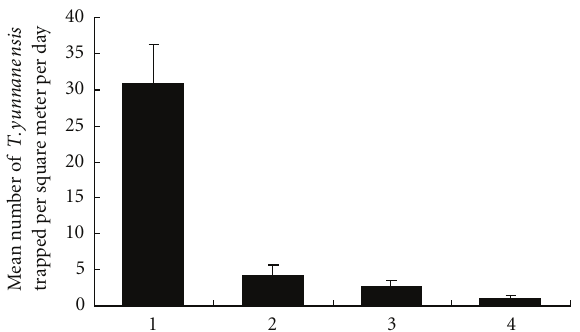
Figure 4: Mean trap catches ( ± SE) per hour of T. yunnanensis on periderm-peeled log bundles during the day (Dec.–Feb. 2006, 2007; Qujing, Yunnan,